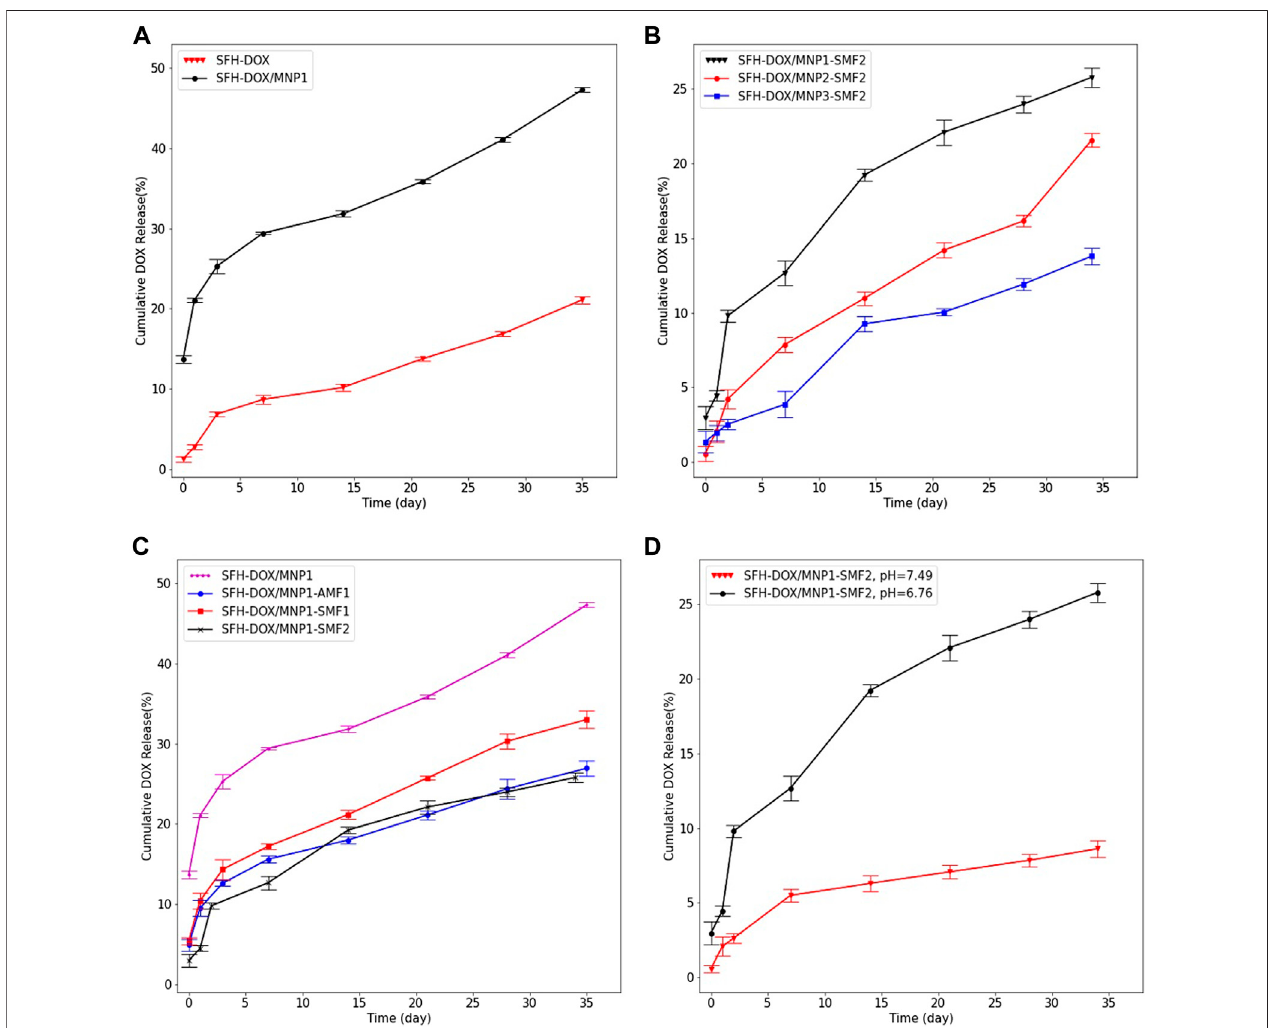
FIGURE4| Evaluationofmultiplestimuli-responsivepropertiesofSFH. Invitro cumulativereleasepro fi leofDOXfrom (A) ;SFHandSFH/MNP1intheabsenceofan EMF, (B) ; different magnetic hydrogels containing different concentrations of MNPs, in the presence of 0.28 T SMF, (C) ; SFH/MNP1 under the various EMF, (D) ; SFH/ MNP1 in two different release buffers acidity. Data are expressed as mean ± SD.